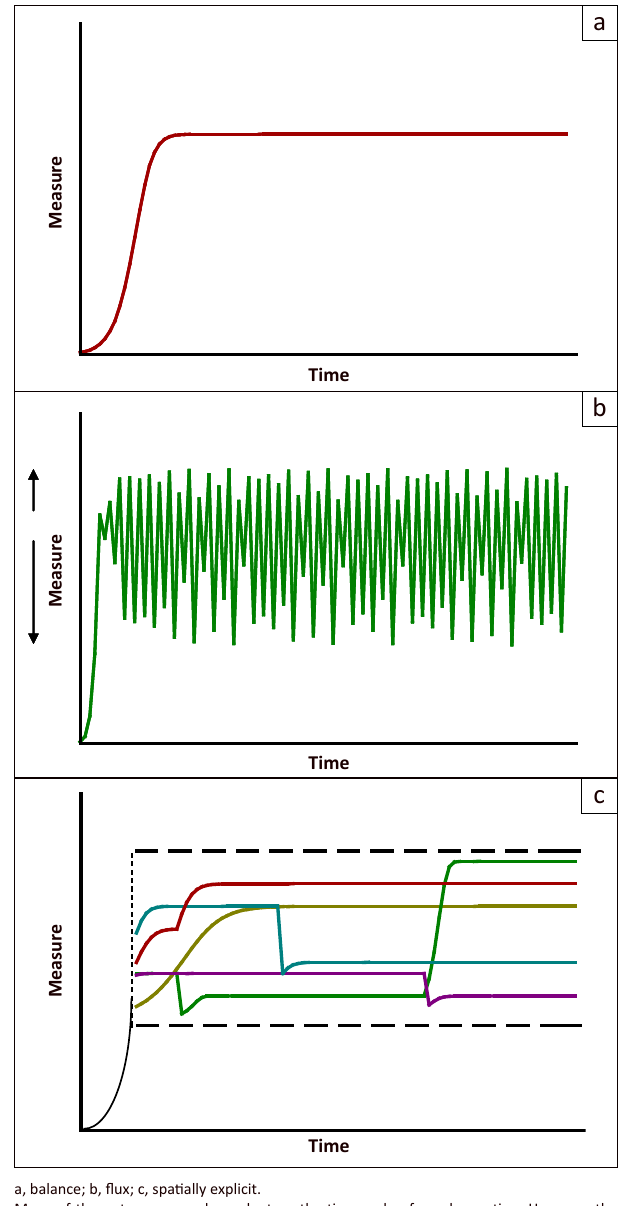
FIGURE 1: Outcomes of the balance versus flux paradigms of ecosystem